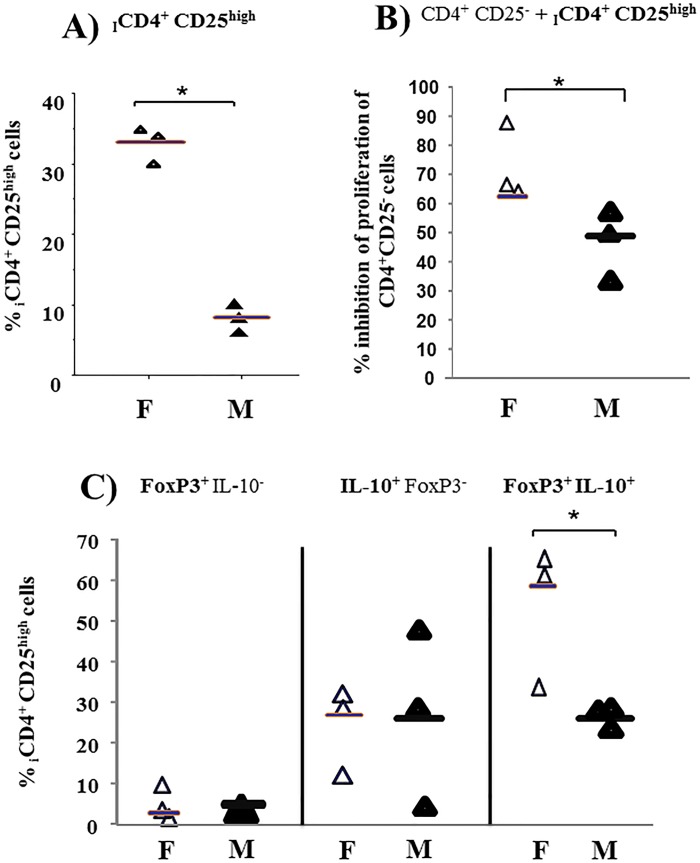
Induction of CD4+CD25high cells from CD4+CD25− cells from foals and mares.1x107 CD4+CD25− lymphocytes sorted from freshly isolated PBMC of foals (F, n = 3, age 1–2 months) and mares (M, n = 3, 5–17 years) were cultured with the cocktail. 4 days later, the cells were harvested, stained for CD25 and resorted for induced CD4+CD25high (I
CD4
+
CD25
high) cells. A) Proportion of ICD4+CD25high cells from foals and mares were measured using flow cytometry. 5x105 CD4+CD25− cells sorted from freshly isolated PBMC were labelled with CFSE and cultured with 5x105 irradiated allogeneic PBMC alone (CD4
+
CD25
−) or in the presence of ICD4+CD25high
(CD4
+
CD25
−
+
I
CD4
+
CD25
high) cells in a ratio of 1: 0.25. After 4 days, the cells were harvested and stained for FoxP3 and IL-10. B) Percentage of proliferation was measured by flow cytometry. Results are shown as percentage inhibition of proliferation of CD4
+
CD25
− cells by ICD4+CD25high cells following stimulation with irradiated allogeneic PBMC. C) Percentage of single positive FoxP3
+IL-10−, single positive IL-10
+FoxP3− and double positive IL-10
+
FoxP3
+ was measured by flow cytometry. Each data point represents 1 horse horizontal bars within values denote medians. An asterisk with line indicates statistical significance difference. Comparisons were performed using non-parametric Mann-Witney U test. *p ≤0.05 was considered significant.